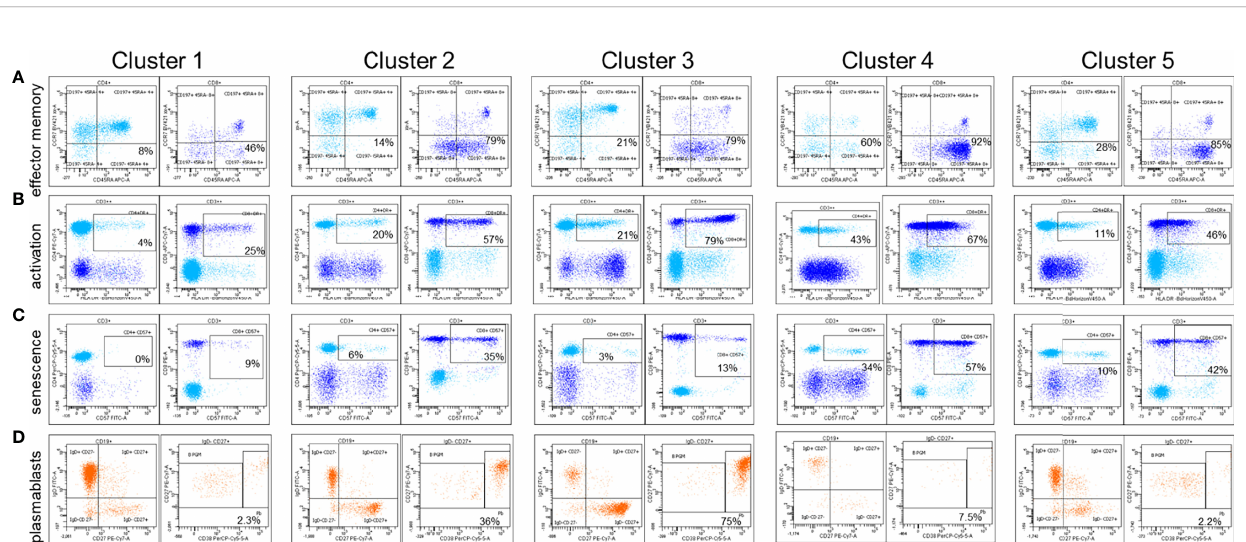
FIGURE 1 | Examples of lymphocyte immunophenotypic characteristics for each cluster of patients. (A) Effector memory lymphocytes are de fi ned as CD197- (CCR7-) CD45RA+/- within CD4+ and CD8+ T cells. (B) Activated lymphocytes within CD4+ and CD8+ T cells are de fi ned by HLA-DR expression (C) Senescent lymphocytes within CD4+ and CD8+ T cells are de fi ned by CD57 expression. (D) Plasmablasts are de fi ned within CD19+ IgD- CD27+ cells as CD38high CD27high cells. B PGM, post germinal memory B cells; Pb,